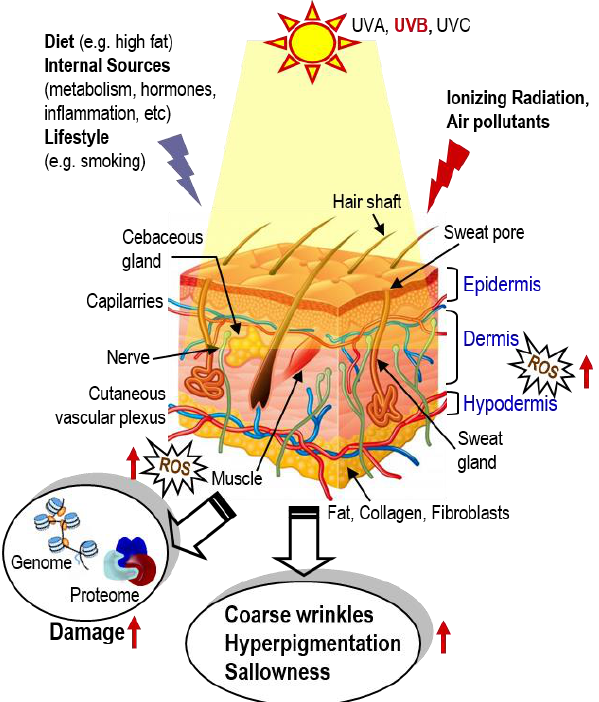
Figure 1. During lifetime, skin is exposed to numerous environmental stressors such as UVA and UVB, ionizing radiation and air pollutants, as well as to stressors that may originate from diet (e.g., high fat diets), internal sources (e.g., metabolism or tissue inflammation) and/or lifestyle (e.g., smoking). While young, these stressors are effectively neutralized by cell protective mechanisms (e.g., the antioxidant transcription factor Nrf2). During aging, defenses are compromised, resulting in accumulating ROS, genome and proteome damage; damage of biomolecules then disrupts normal cell signaling and homeodynamics, resulting in (among others) coarse wrinkles, hyperpigmentation and skin shallowness.